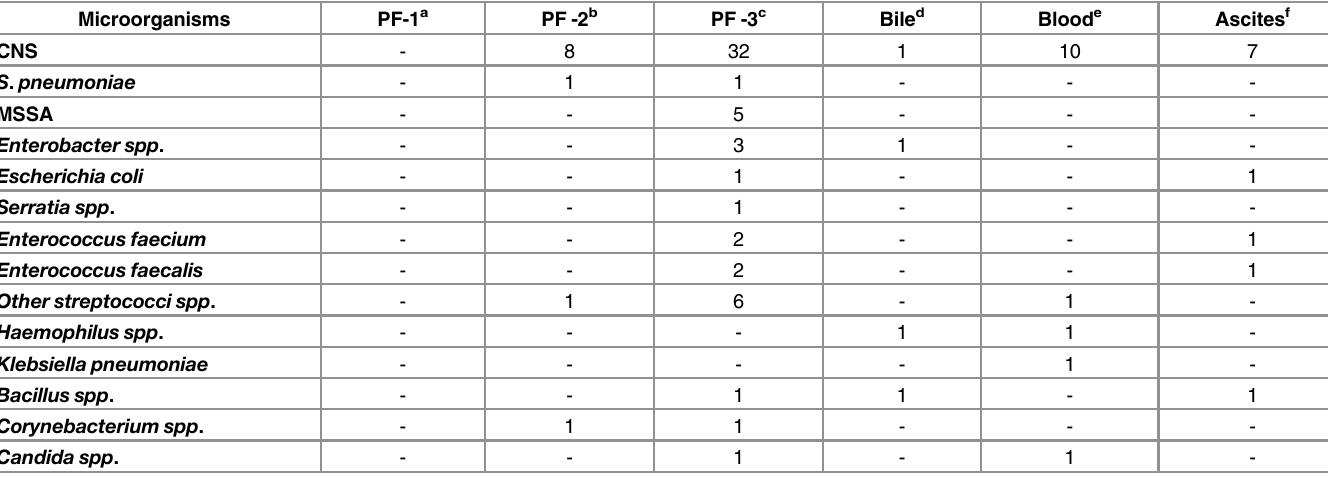
Table 2. Microorganisms isolated in the preservation fluid, blood, and bile samples from the donor and in the ascites samples from the recipients. Microorganisms